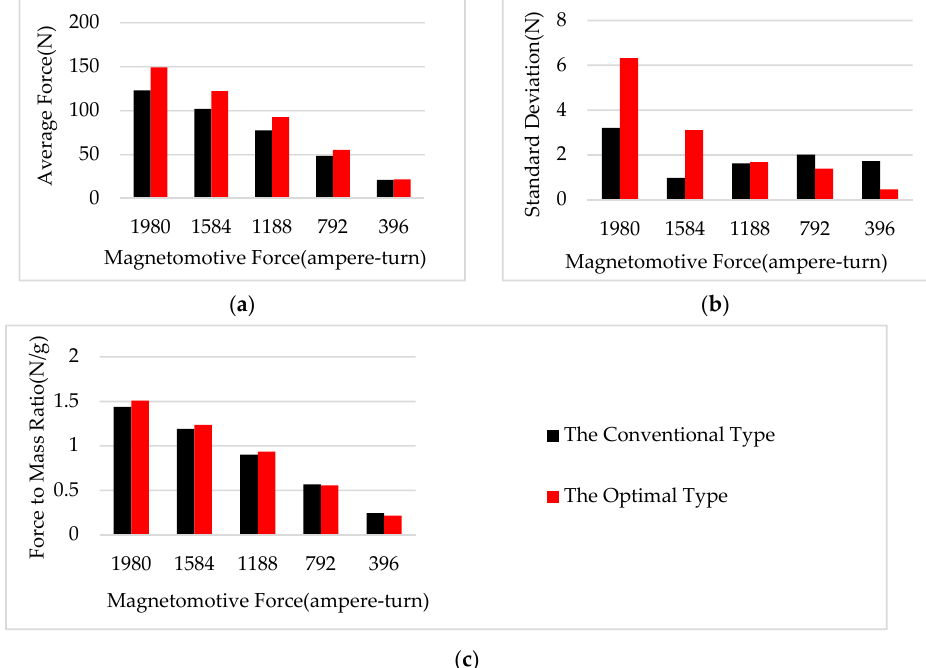
Figure 9. Experimental test results of the static force versus displacement in different magnetomotive force condition.